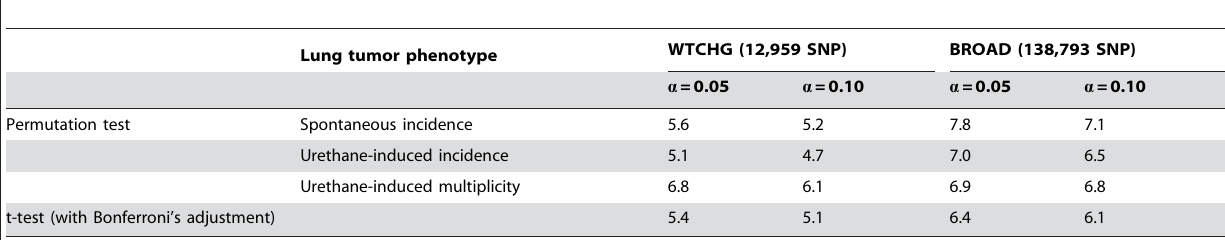
Table 2. Threshold probabilities (expressed as 2 log P) corresponding to experiment-wide type I risk errors a =0.05 and a =